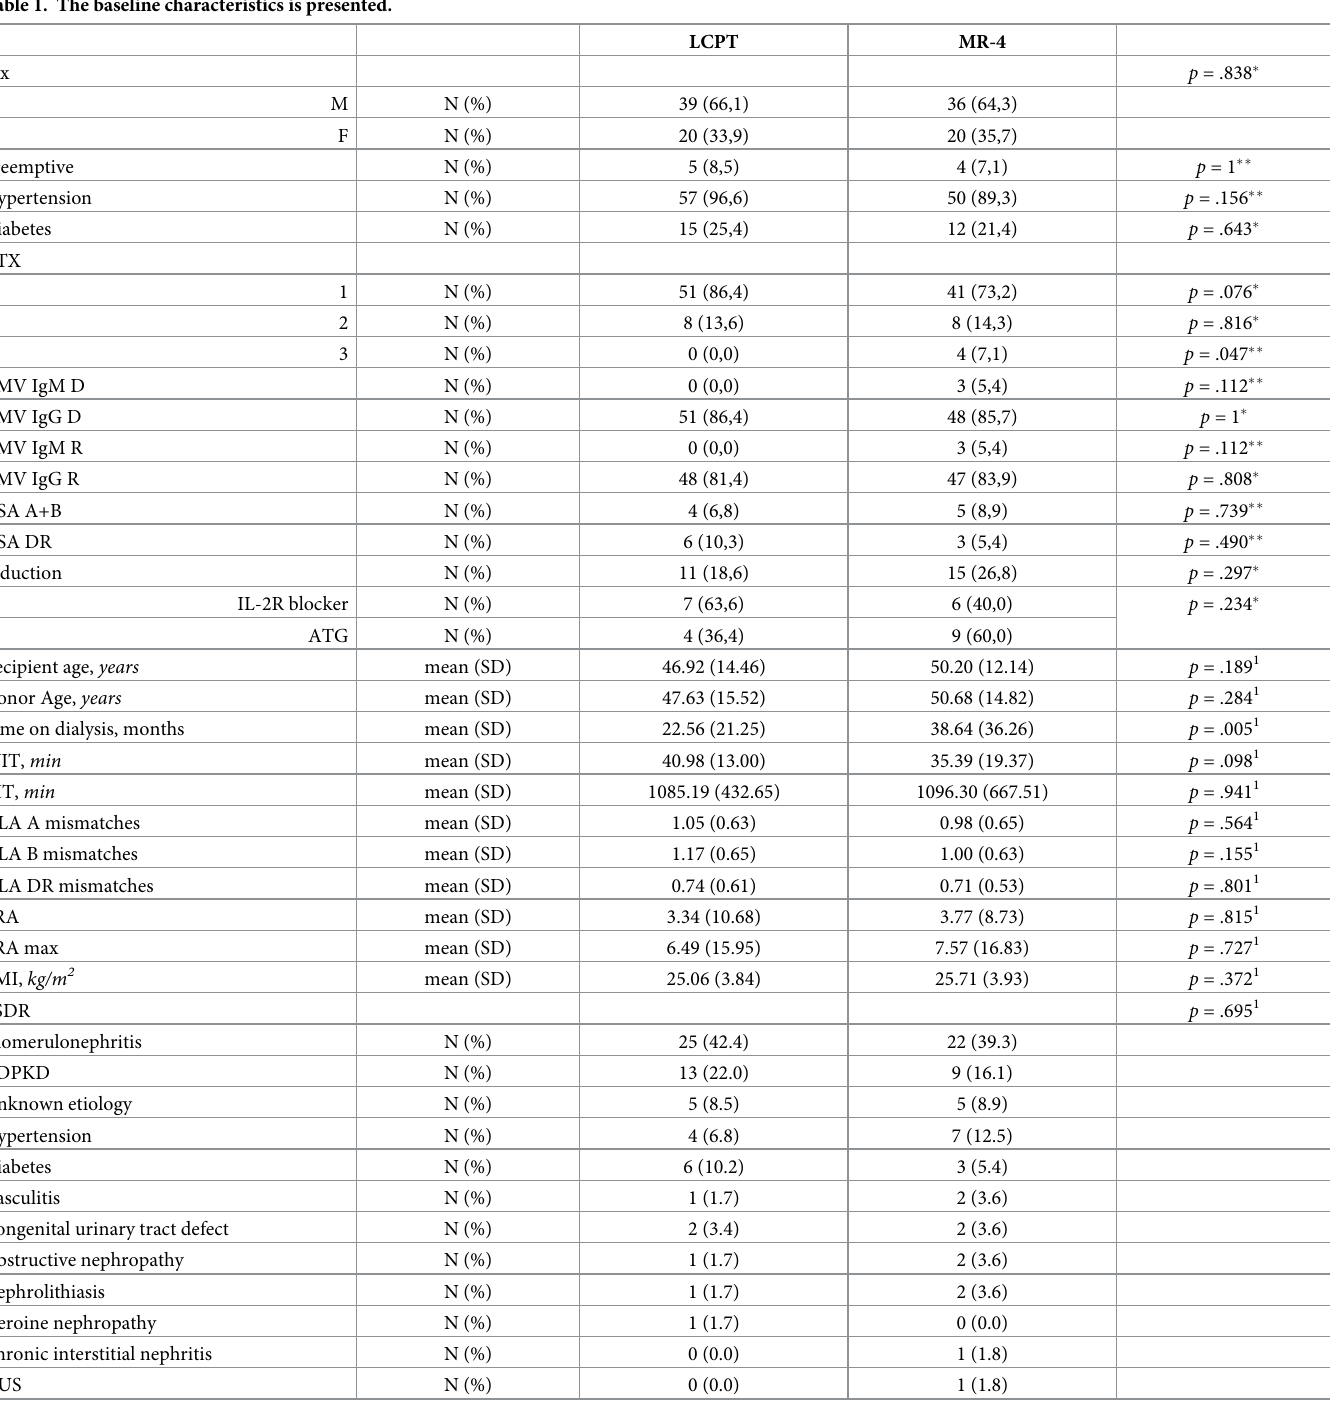
Table 1. The baseline characteristics is